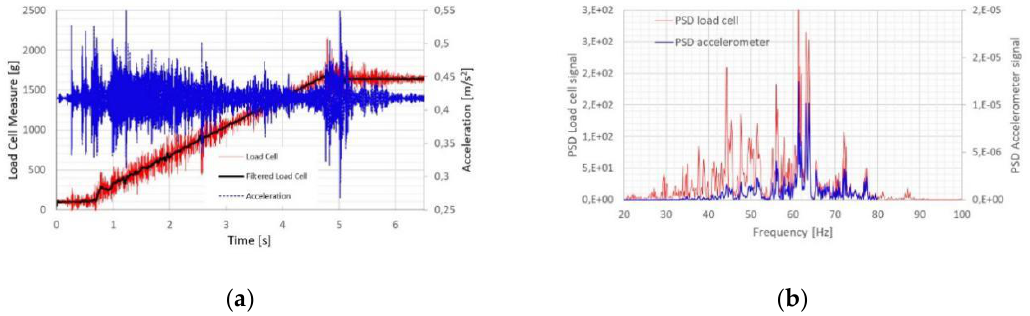
Figure 4. ( a ) Load cell signal (red), filtered load cell signal (black) and acceleration signal (blue) for a test on the test-bench. ( b ) PSD of the signals.